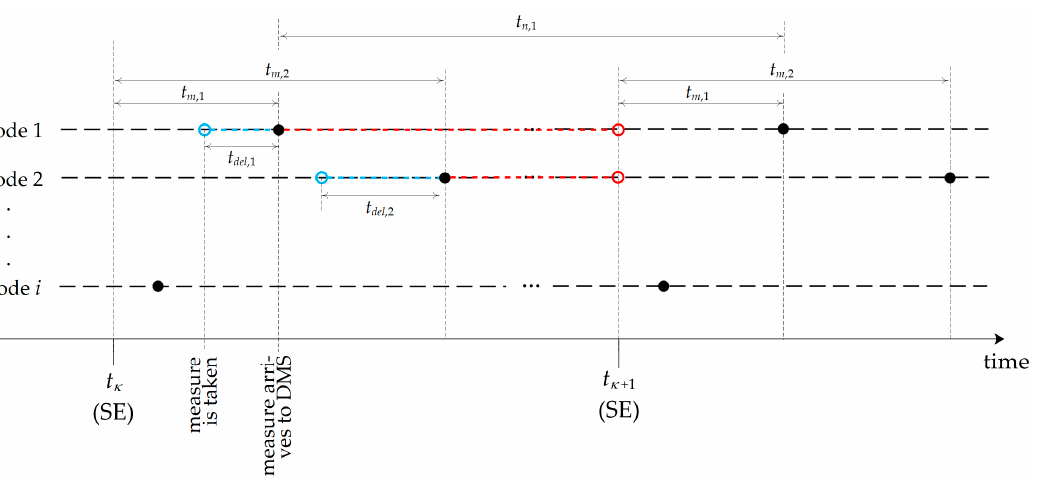
Figure 9. Nonsynchronicity between measurements.